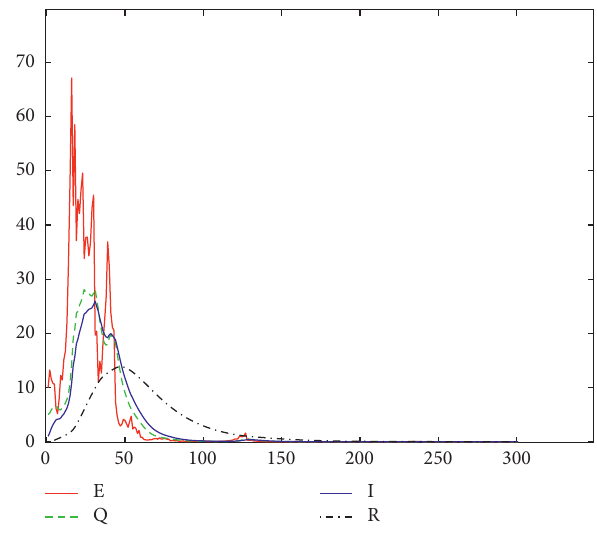
Figure 2: The epidemic extinction with stochastic